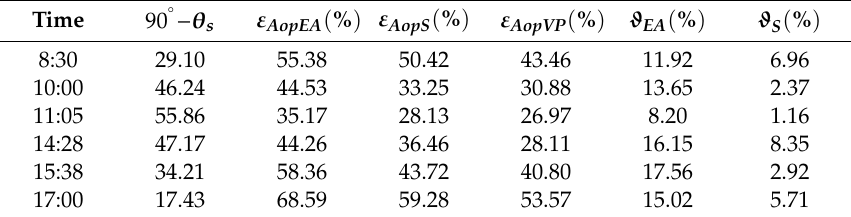
Table 3. Similarity and improvement of equisolid angle imaging, stereographic imaging, two-dimensional Rayleigh simulation, and actual measurement.